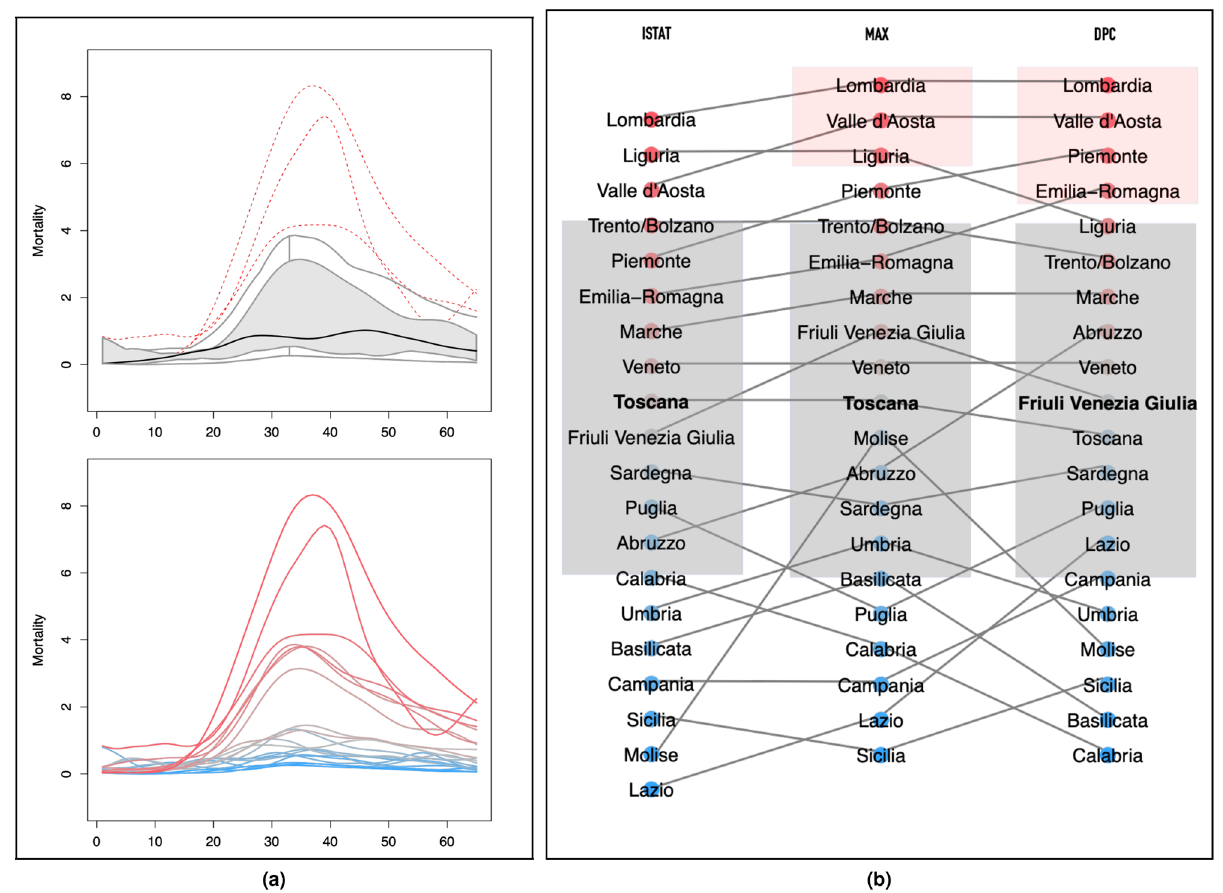
Figure 3. Functional boxplot and ranking. ( a ) Functional boxplot of the MAX data set (top) and MAX mortality curves (bottom) color-coded according to their ranking, as shown in the MAX column of ( b ). In the boxplot, Toscana is the median (black continuous line); Lombardia, Valle d’Aosta and Liguria are identified as outliers (red dashed lines); and the 50% innermost “box” (grey area) include the curves for Trento/Bolzano, Emilia-Romagna, Marche, Friuli Venezia Giulia, Veneto, Toscana, Molise, Abruzzo, Sardegna, Umbria, and Basilicata. Note that the “box” is skewed upwardly. ( b ) Rankings of the ISTAT (left), MAX (center) and DPC (right) mortality curves. The median regions are in bold, gray rectangles mark the 50% innermost boxes, and pale red rectangles mark outliers (no region is labeled as an outlier in the ISTAT data set; see Methods). The dots representing each region are color-coded (from intense red, through gray, to intense blue) according to their signed depth values (see Methods). In all three data sets, Lombardia’s curve is the most extreme at the very top of the ranking and, in contrast, Veneto’s curve is deep in the bulk close to the median (Toscana for ISTAT and MAX, Friuli Venezia Giulia for DPC). Segments joining the regions across the three rankings show how the top portion remains rather stable, while the mid- and bottom portions contain several crossings. Regions at the top are those characterized by “exponential” epidemics (Group 1), while regions in the middle and at the bottom are those with “flat(tened)” epidemics (Group2), whose curves can more easily switch in their depth